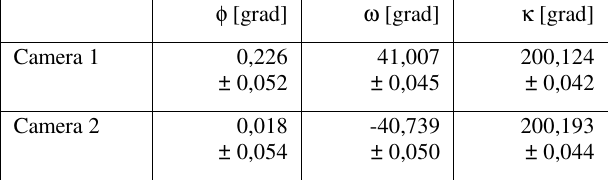
Table 1: Relative orientation of oblique images versus vertical image (camera 0) based on an single step orientation in a test bed